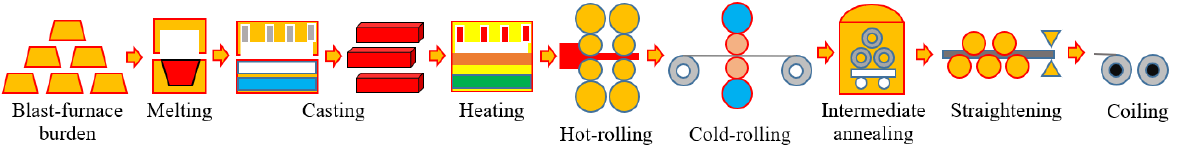
Figure 2. Production process of aluminum alloy plate and strip.